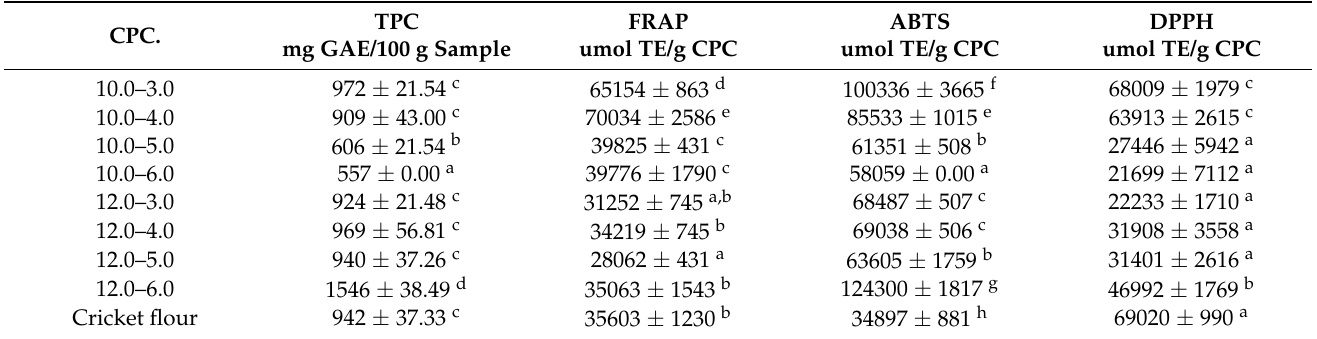
Table 4. Antioxidant activity of cricket protein concentrate (CPC) using FRAP, ABTS, and DPPH methods.